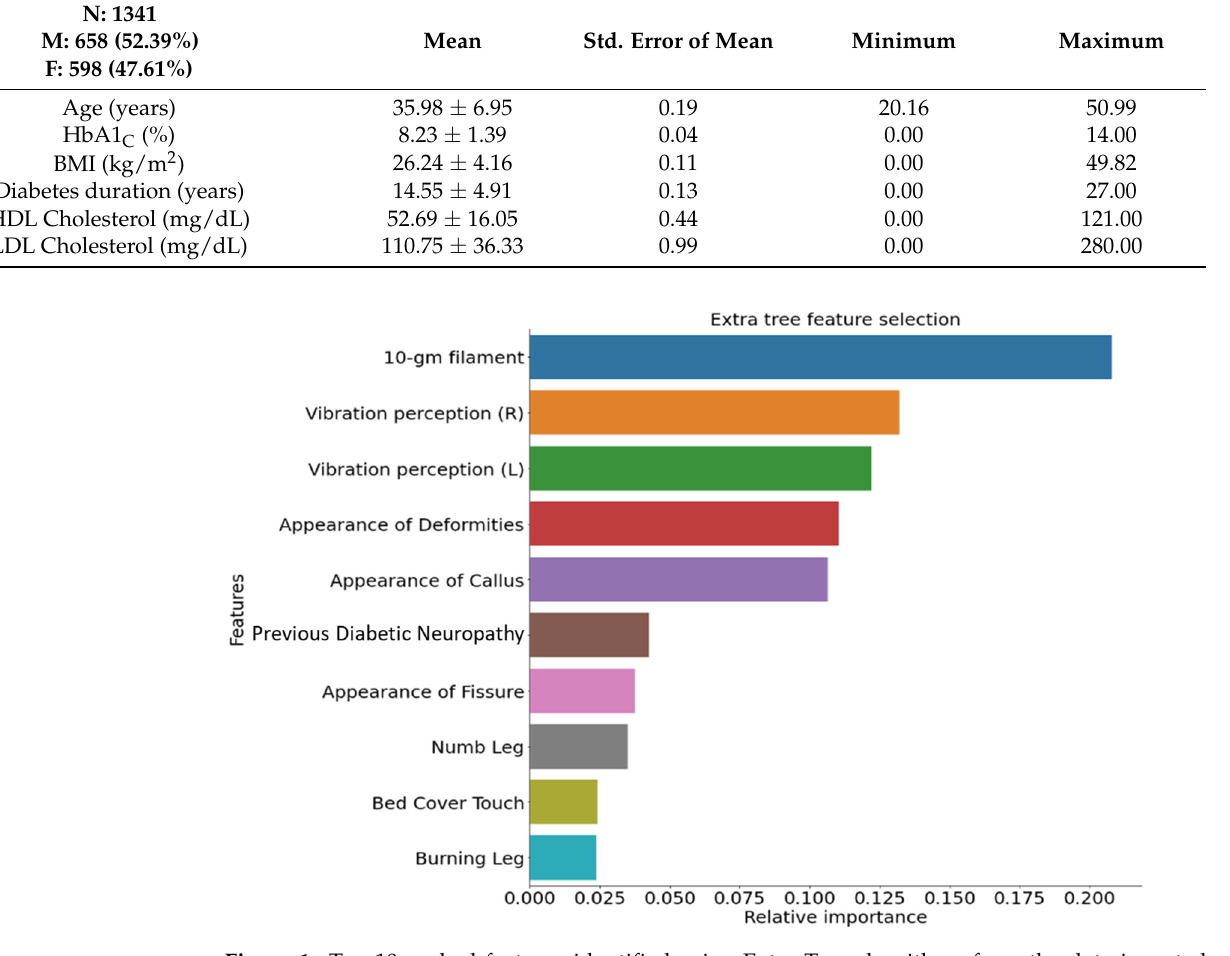
Figure 1. Top-10 ranked features identified using Extra Tree algorithms from the data imputed uti- lizing the MICE